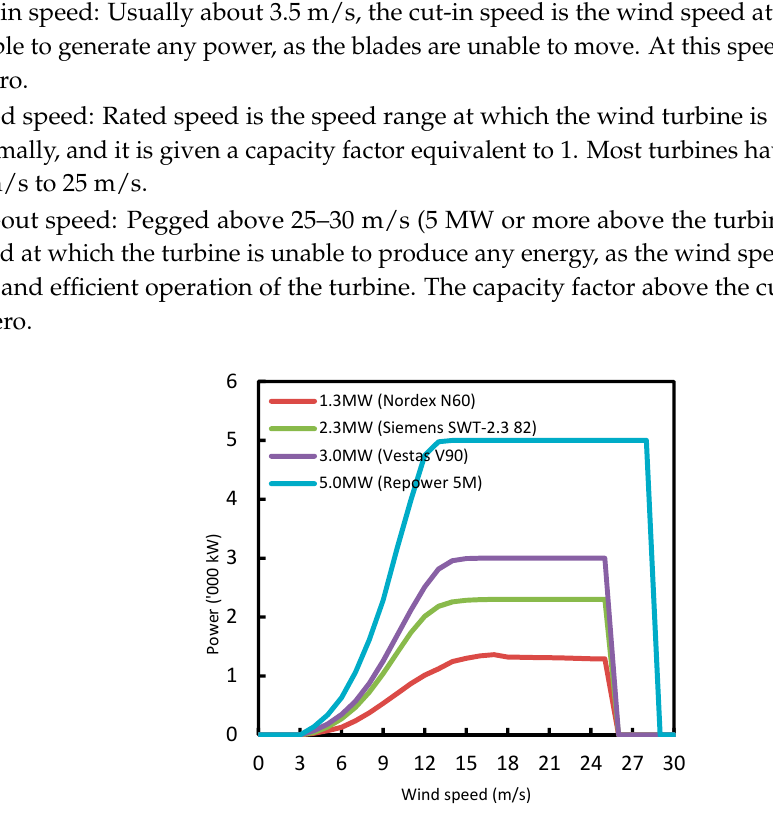
Figure 2. Conceptualized wind power curves for different power-rated turbine models.